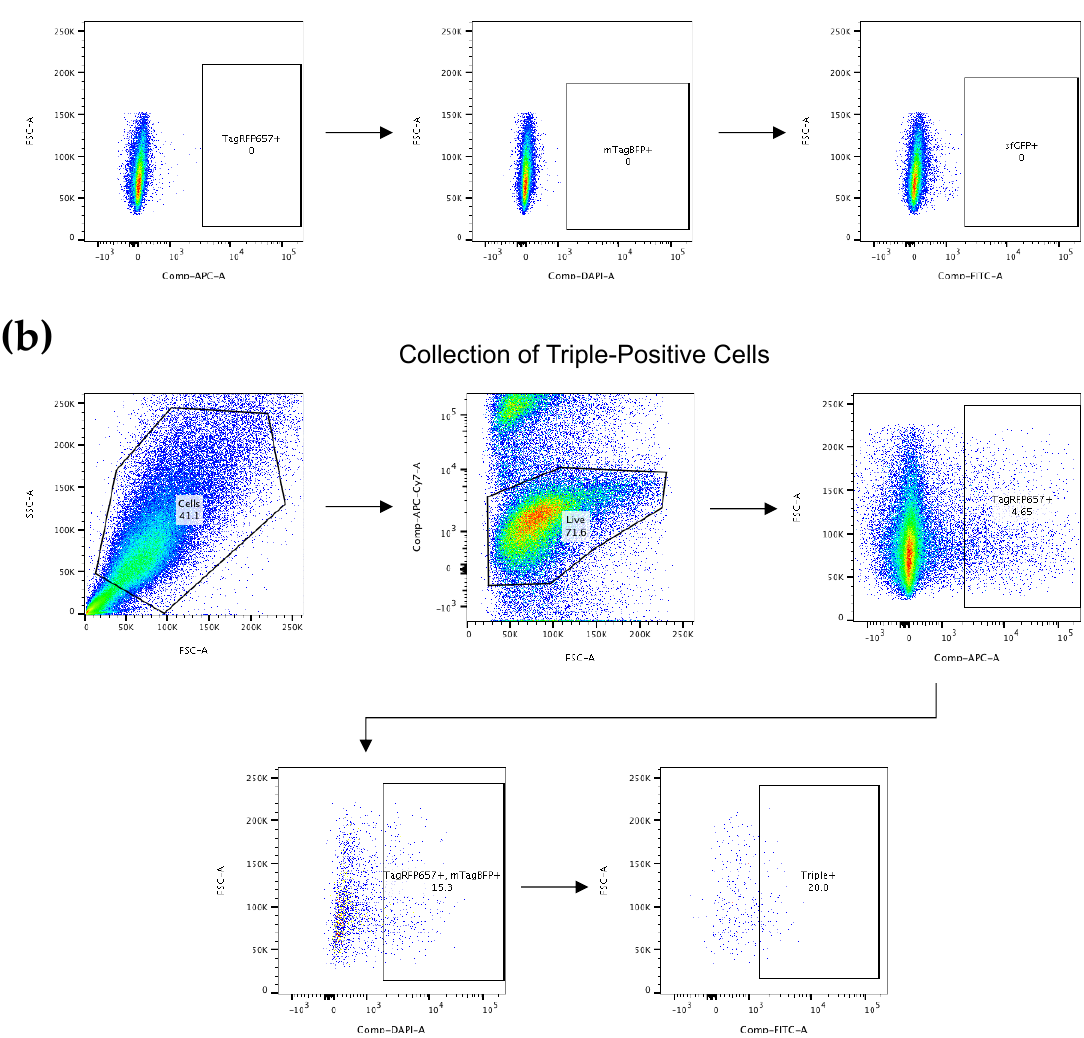
Figure A1. FACS for CRISPR-edited cells. ( a ) Gating setup using DNA-free negative control samples. Shown is the use of a DNA-free negative control sample to set accurate gates for fluorophore-positive (i.e., transfected) cells. Gates are set for each respective channel to ensure that only genuine fluorophore-positive cells will be sorted during FACS. ( b ) Example of FACS for CRISPR-edited NZM40 human melanoma cells. Shown is an example of the sequential gating strategy for sorting triple-positive transfected cells in practice, which selects sequentially for the following: the true cell population; live cells only; cells expressing TagRFP657; cells also expressing mTagBFP; and cells also expressing sfGFP. Hence, all cells that are eventually sorted into the final collected population are live, triple-positive